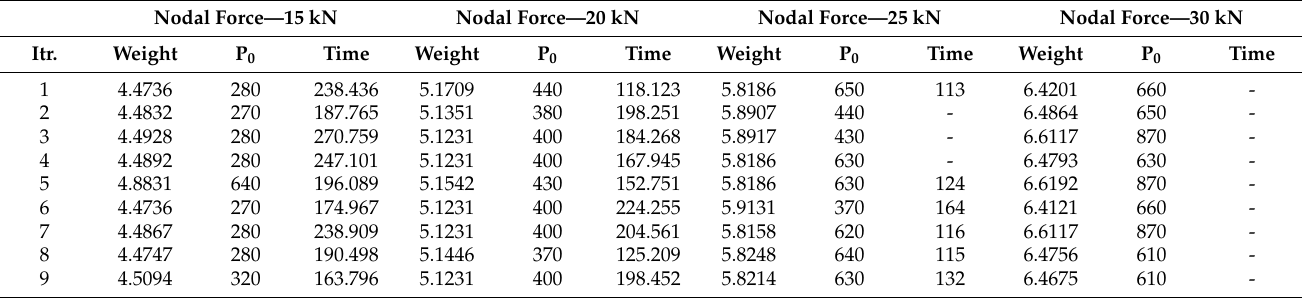
Table 6. Optimization results of the weights of the new truss at different nodal forces.